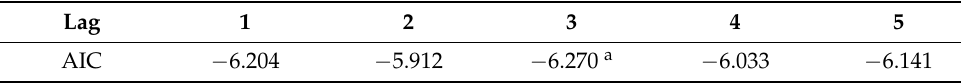
Table 5. Selecting the number of lags for the VAR model.